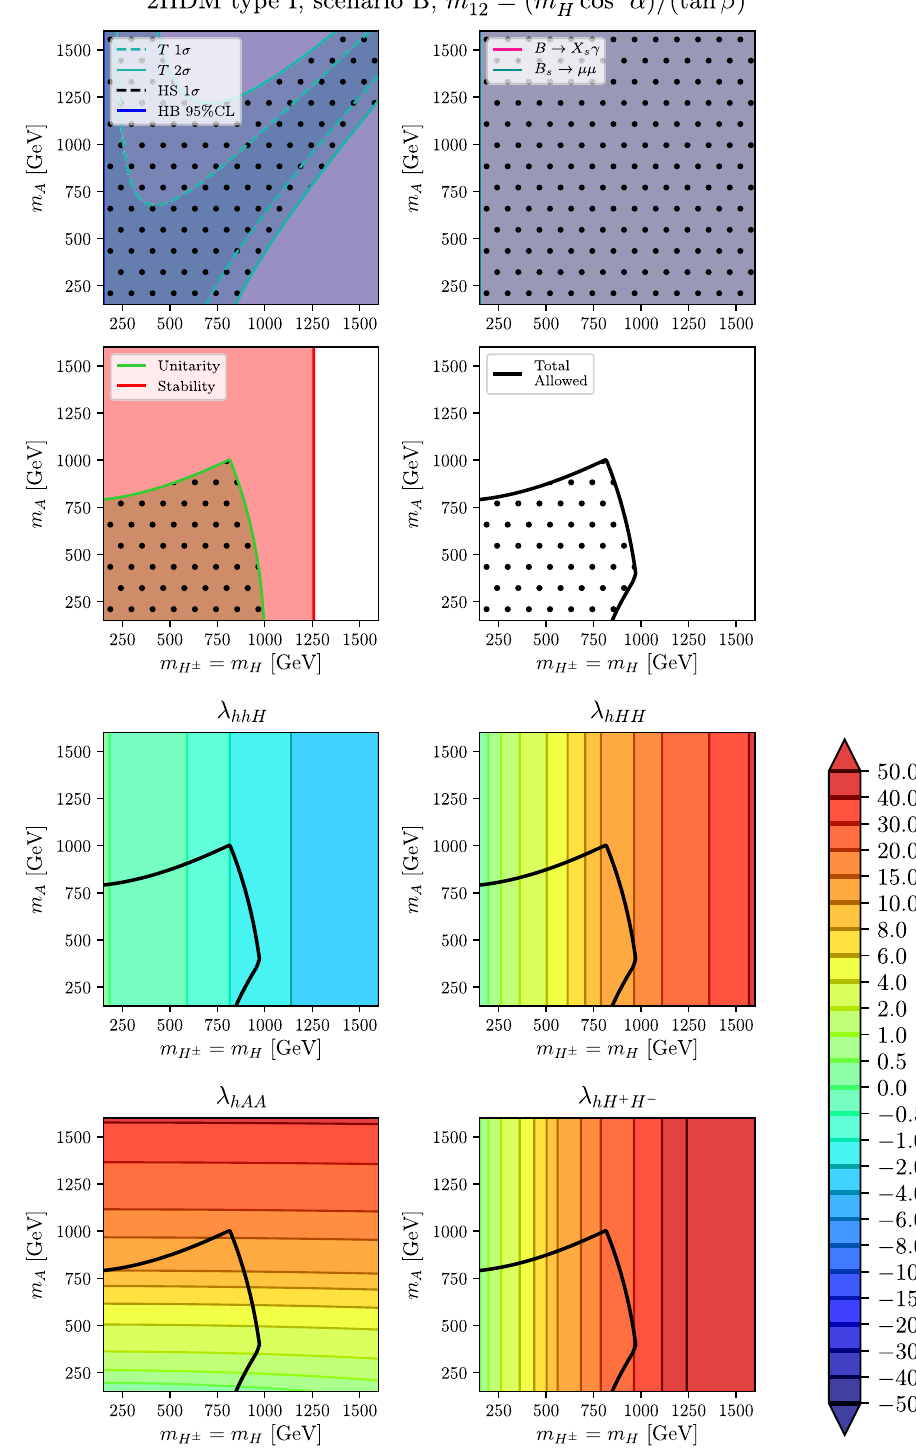
Fig. 19 PredictionsfortripleHiggscouplingsinthe2HDMtypeI,sce- nario B, in the ( m H ± = m H , m A ) plane with c β − α = 0 . 2, tan β = 10 = ( m 2 and m 2 cos 2 α)/( tan β) . Upper four plots: allowed regions as H 12 in Fig. 8. The light blue lines in the upper left plot correspond to the